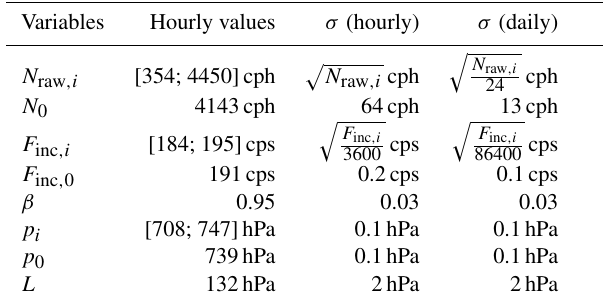
Table 5. Compilation of all direct observations and constants as well as the associated uncertainties σ at hourly and daily scales. The units cph and cps stand for counts per hour and second, respectively. Brackets show the minimum and maximum within the time